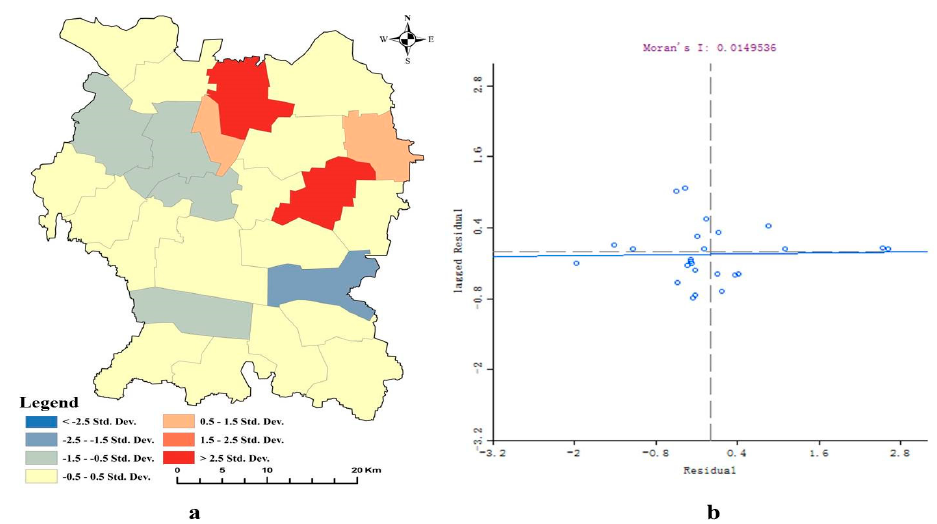
Figure 5. Parameter estimation results of GWR. ( a ) Residual of GWR’s distribution; ( b ) Moran’s I . Using the GWR model, the driving variables’ regression coe ffi cients were estimated (Table 4). The regression coe ffi cients of Pod, Pog, Dic, and Hon showed opposite characteristics, except GDP and